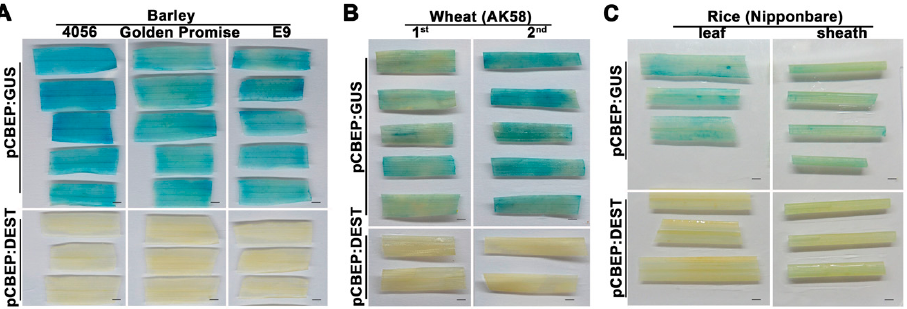
Figure 4. Transient expression with pCBEP:GUS in barley, wheat, and rice plants. ( A ). Expression of GUS in the first leaves of different barley varieties. E9 was used as control. ( B ). Expression of GUS in the 1st and 2nd leaves of wheat plants (AK58). ( C ). Expression of GUS in leaf and sheath of rice plants (Nipponbare). The plants were syringe-infiltrated ( A , B ) or vacuum-infiltrated ( C ) with 0.5 OD 600 of AGL1 (pCBEP:GUS) following 1 d moisturizing/2 d darkness treatment; samples were collected at 4 dpi. Expression of empty vector (pCBEP:DEST) used as a negative control. Scale bars = 1.5 mm.